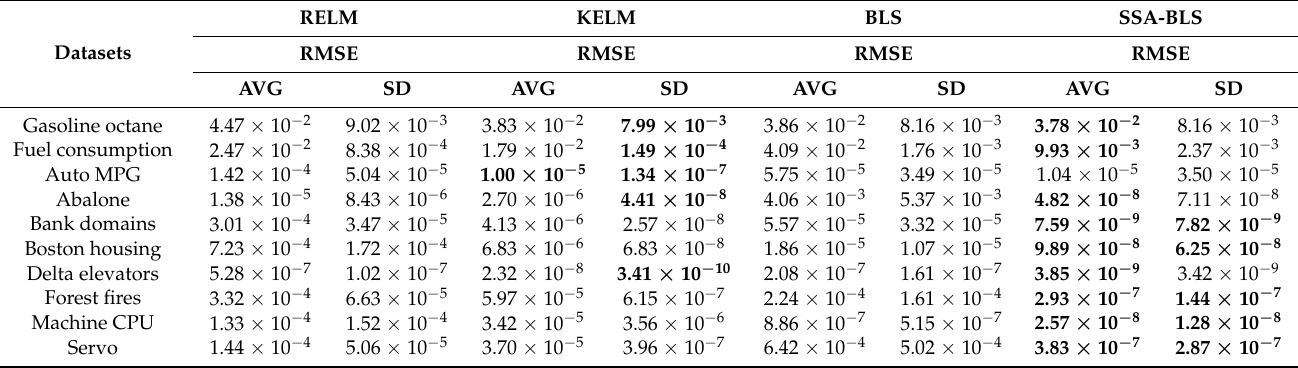
Table 3. The RMSE of the four algorithms on the training